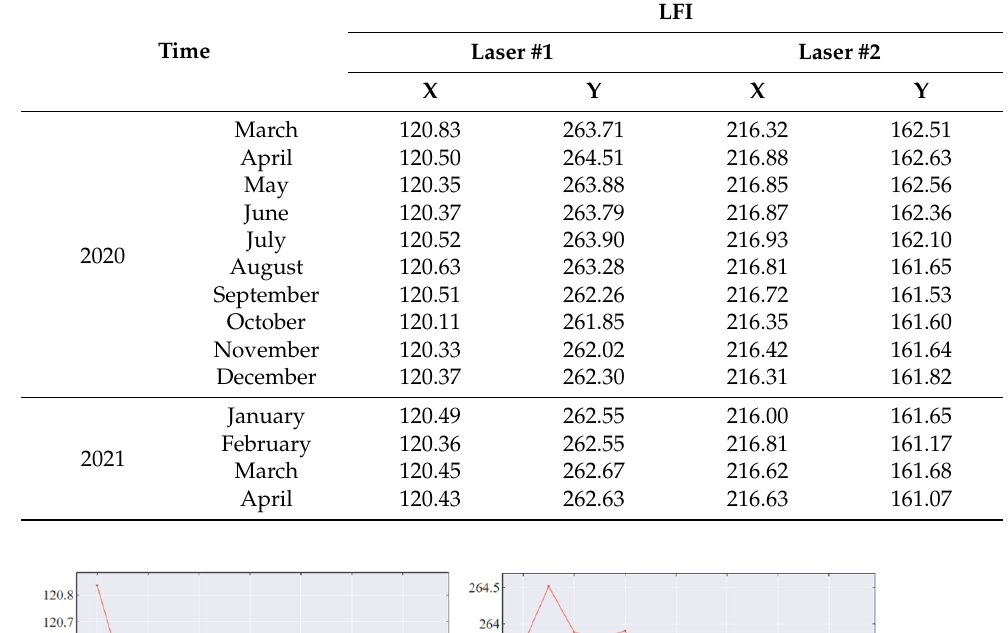
Table 4. Statistical results of monthly mean of spot centroid coordinates of the laser footprint image (LFI; unit: pixel).